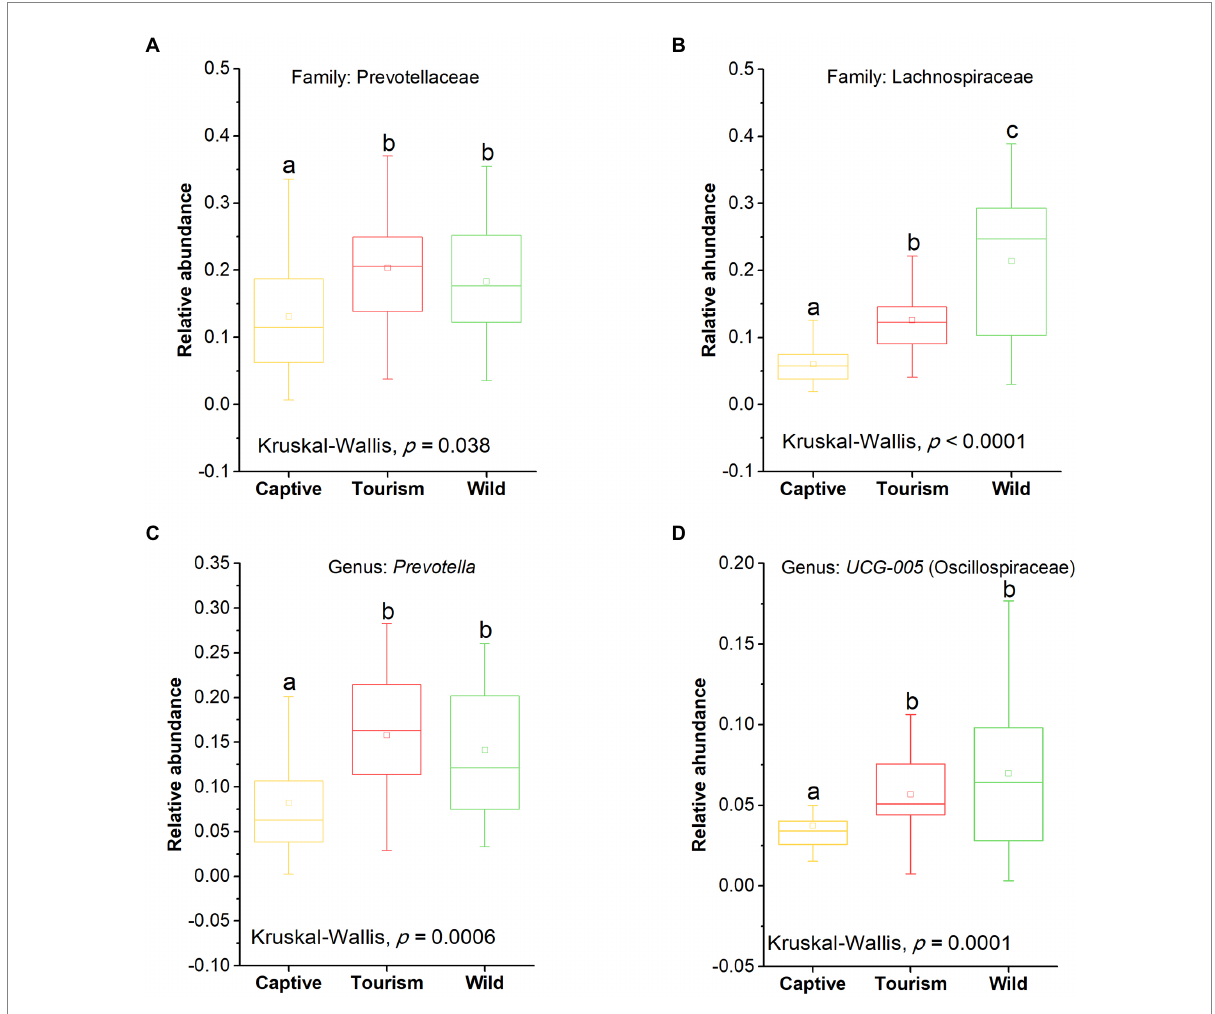
FIGURE 4 Variation in fecal bacterial taxonomy across three study groups. (A) and (B) Comparison of the predominant families. A: Prevotellaceae, B: Lachnospiraceae. (C) and (D) Comparison of the predominant genera. A: Prevotella , B: UCG-005 . A Kruskal-Wallis test was used to evaluate the variation across three groups. Post-hoc tests (Tukey–Kramer test) for pairwise comparison tests (p values were adjusted by FDR). Letters in (A) , (B) , (C) and (D) represent significant